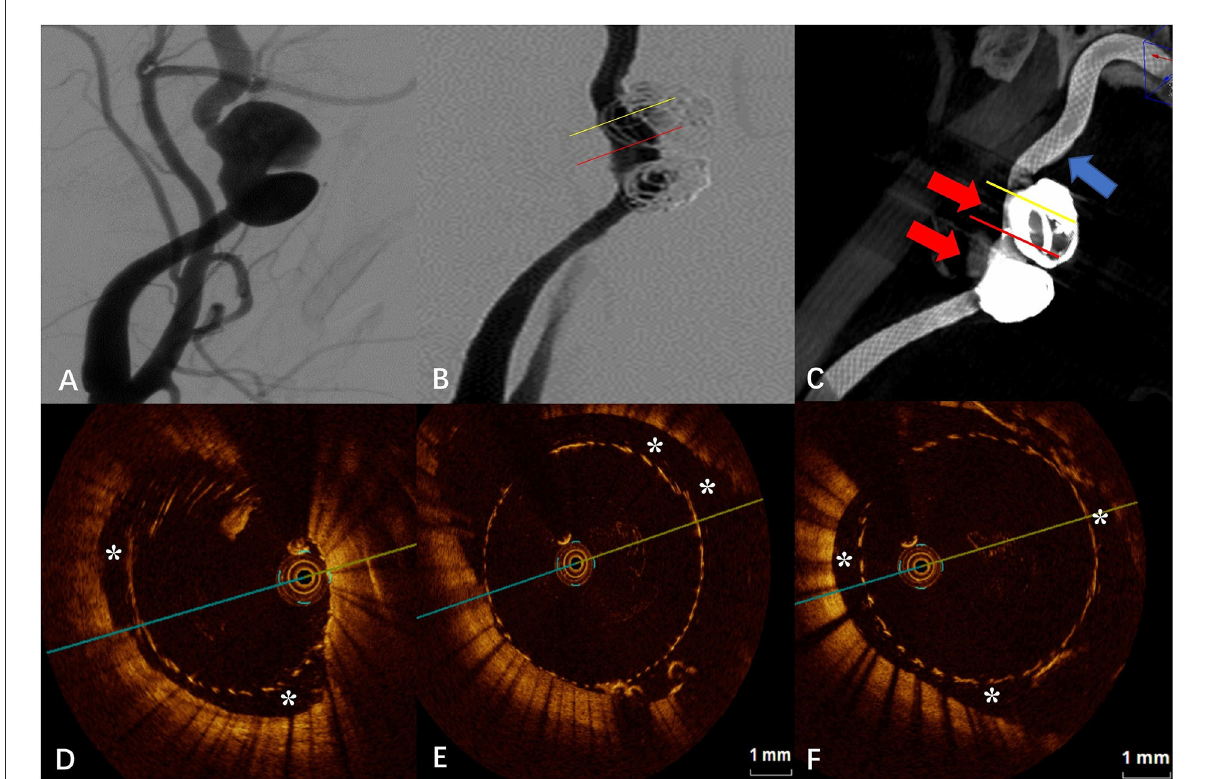
FIGURE2 (A) Digital subtraction angiography (DSA) before the flow-diverter placement. (B) Digital subtraction angiography (DSA) just after the flow-diverter placement. (C) Vaso CT images. Localized malapposition in distal parent artery (blue arrow) and proximal parent artery with good apposition of the FD to the wall. Artifacts near the aneurysm neck that disturb the evaluation of apposition by Vaso CT (red arrows). (D) OCT image. Corresponding to localized malapposition [blue arrow in (C) ] confirmed by Vaso CT (*). (E) OCT image. The corresponding yellow line in (B,C) . Eccentric communication malapposition near the aneurysm neck (*). (F) OCT image. The corresponding red line in (B,C) . Circumferential communication malapposition at the aneurysm